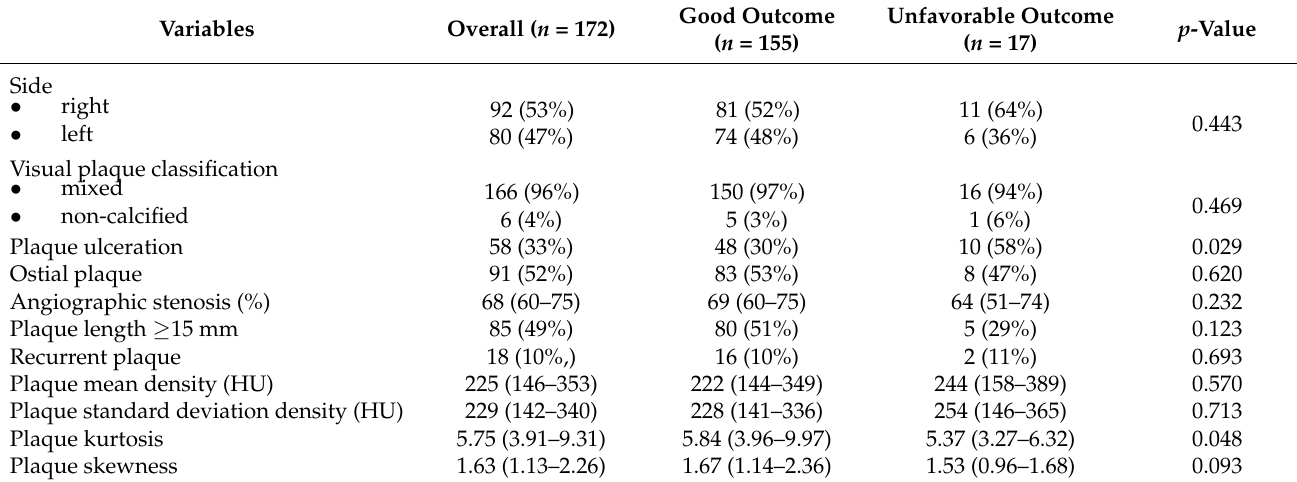
Table 2. Main CTA features, plaque visual assessment and texture parameters.